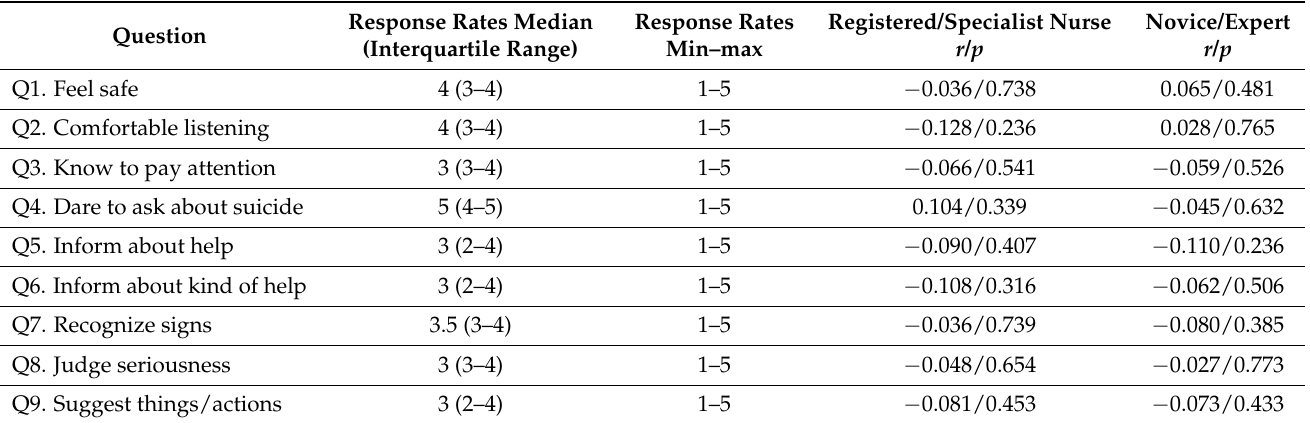
Table 2. Response rates for each question and correlation coefficients ( r )/ p values for the association of self-perceived competence rankings with education (registered vs. specialist nurses) and with professional experience (novice, <5 years vs. expert, ≥ 5 years) in the ambulance service.